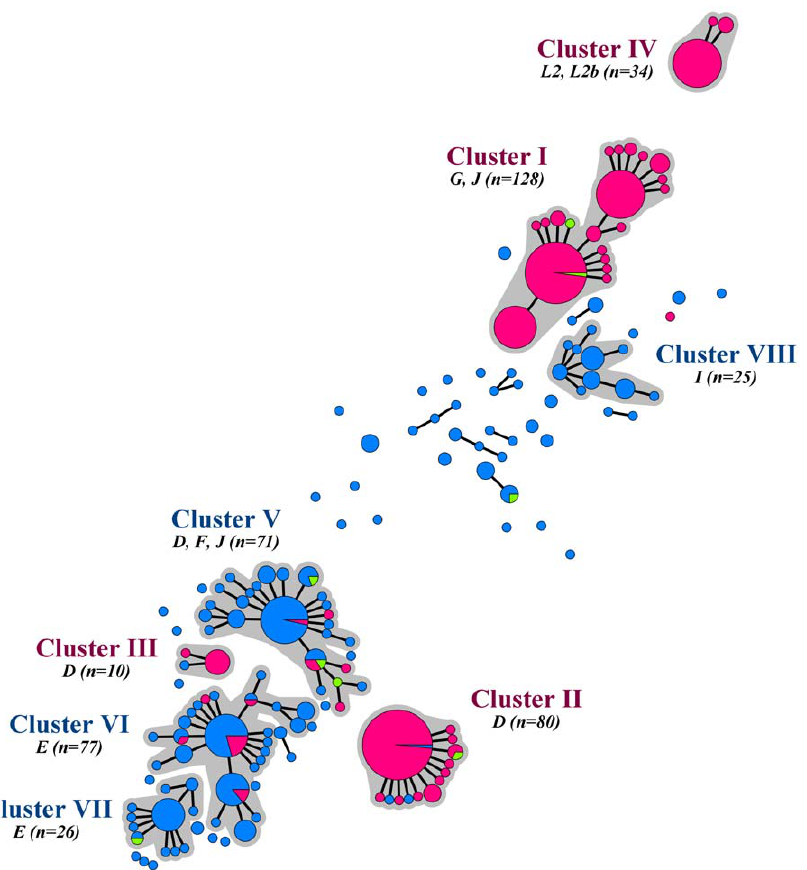
Figure 2. Minimum spanning tree showing the sexual orientation of the host of 526 Chlamydiatrachomatis -positive samples from MSM and heterosexuals in Amsterdam between July 2008 and May 2010. Sizes of the node discs are proportional to the number of samples of each sequence type; branches show single locus variants (SLV); halos indicate clusters based on SLV; and letters indicate ompA genovar type. The color coding is: pink, men who have sex with men only (n=262); green, men who have sex with men and women (n=8); and blue, heterosexual men and women (n=256).